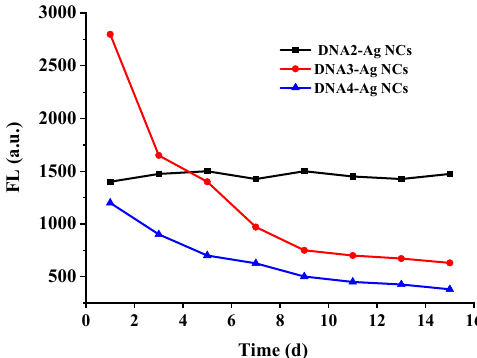
Figure 4. The stability of the prepared DNA-Ag NCs.